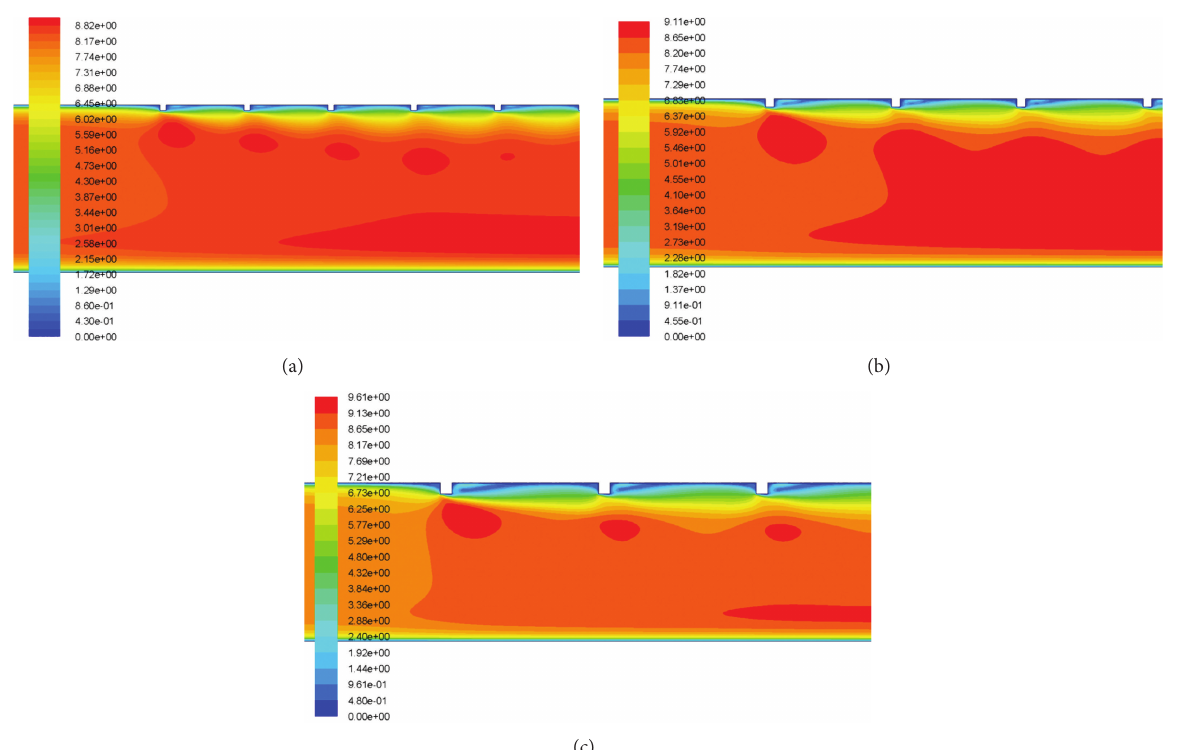
Figure 8: The contour plot of velocity for Re = 18,000 and 𝑃/𝑒 = 14.29 at a relative roughness height of (a) 𝑒/𝐷 = 0.03 , (b) 𝑒/𝐷 = 0.42 , and (c) 𝑒/𝐷 = 0.06